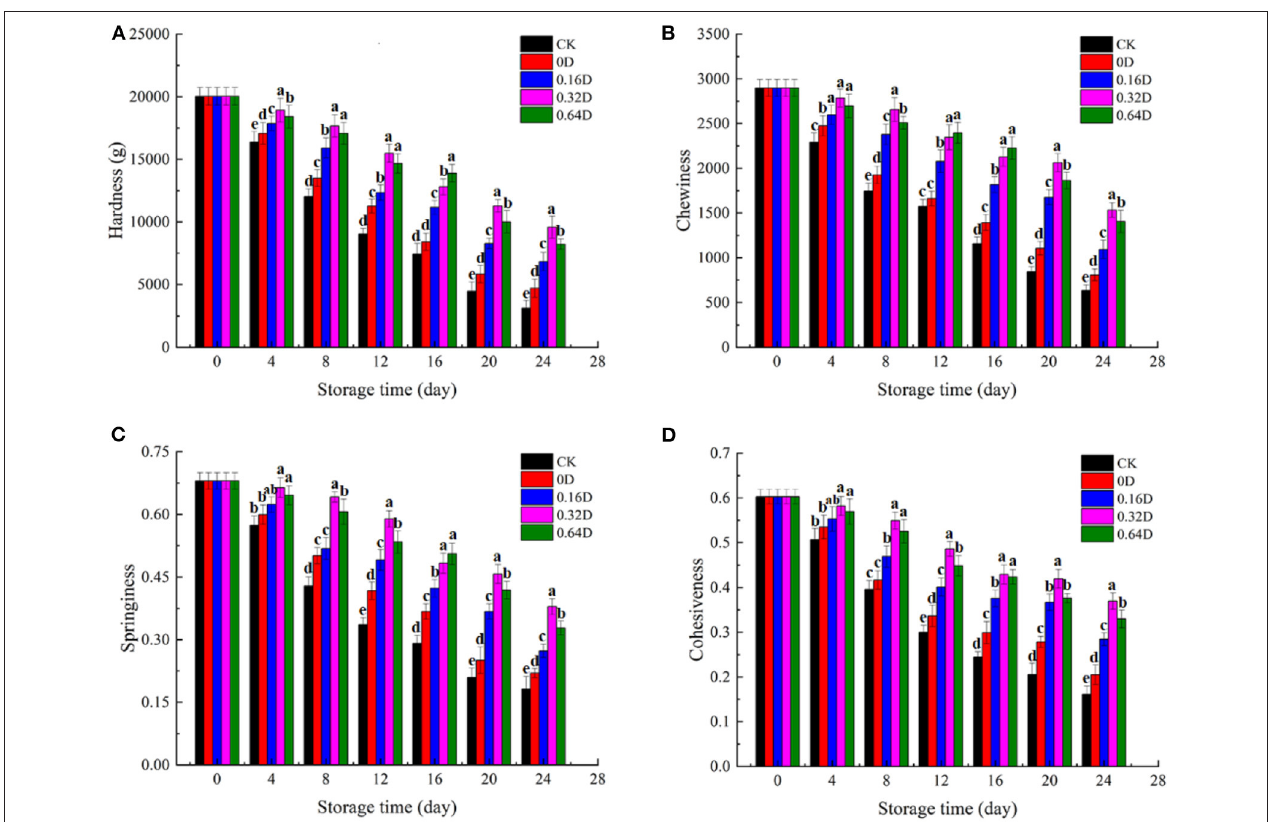
FIGURE 5 | Changes in (A) hardness, (B) chewiness, (C) springiness, and (D) cohesiveness of turbot samples during the refrigerated storage [CK, washed with deionized water; 0D, immersed in weakly acidic electrolytic water (WAEW) for 10min, followed by coating with locust bean gum–sodium alginate (LBG-SA)-active coating; 0.16D, immersed in WAEW for 10min, followed by coating with LBG-SA coating with 0.16-g/L daphnetin; 0.32D, immersed in WAEW for 10min, followed by coating with LBG-SA coating with 0.32 g/L daphnetin; 0.64D, immersed in WAEW for 10min, followed by coating with LBG-SA coating with 0.64-g/L